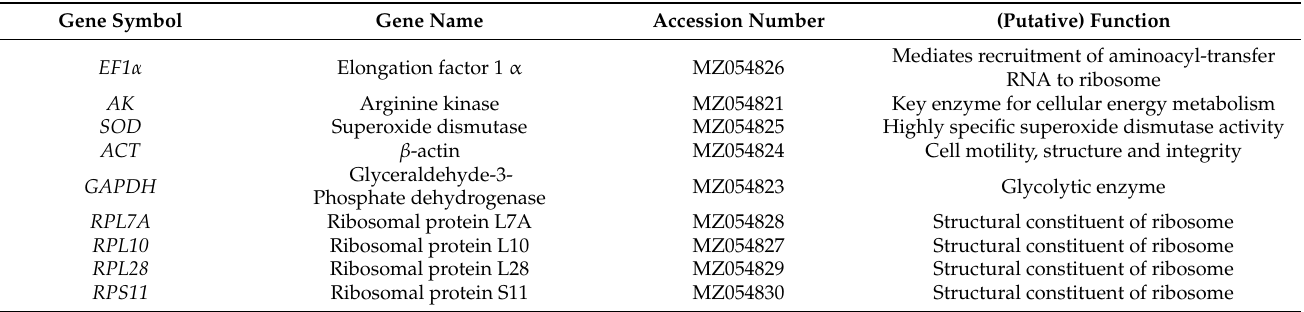
Table 1. GenBank accession numbers and functions of candidate reference genes.